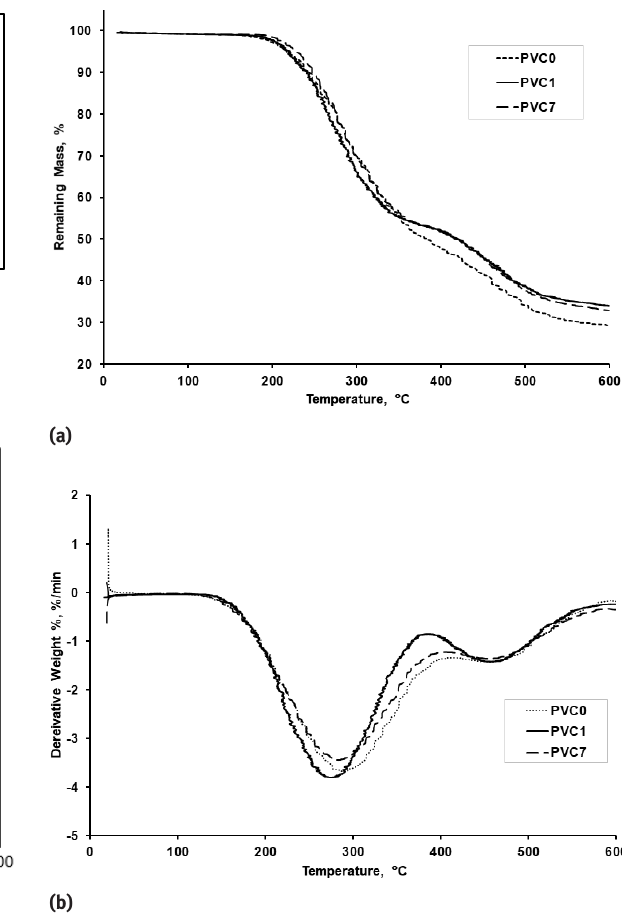
Figure 3: Effects of individual ZB and multiple ZB-ATH-MH